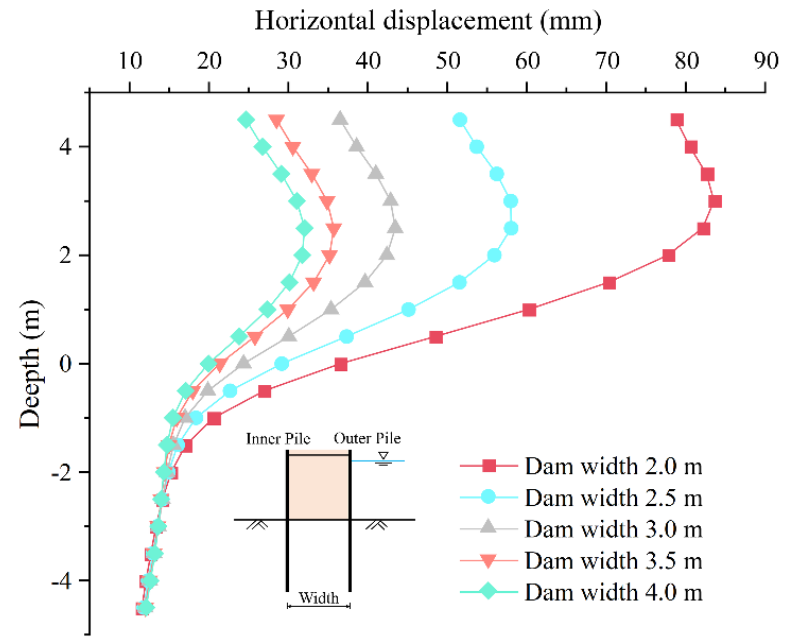
Figure 15. Pile horizontal displacement of different dam width conditions.